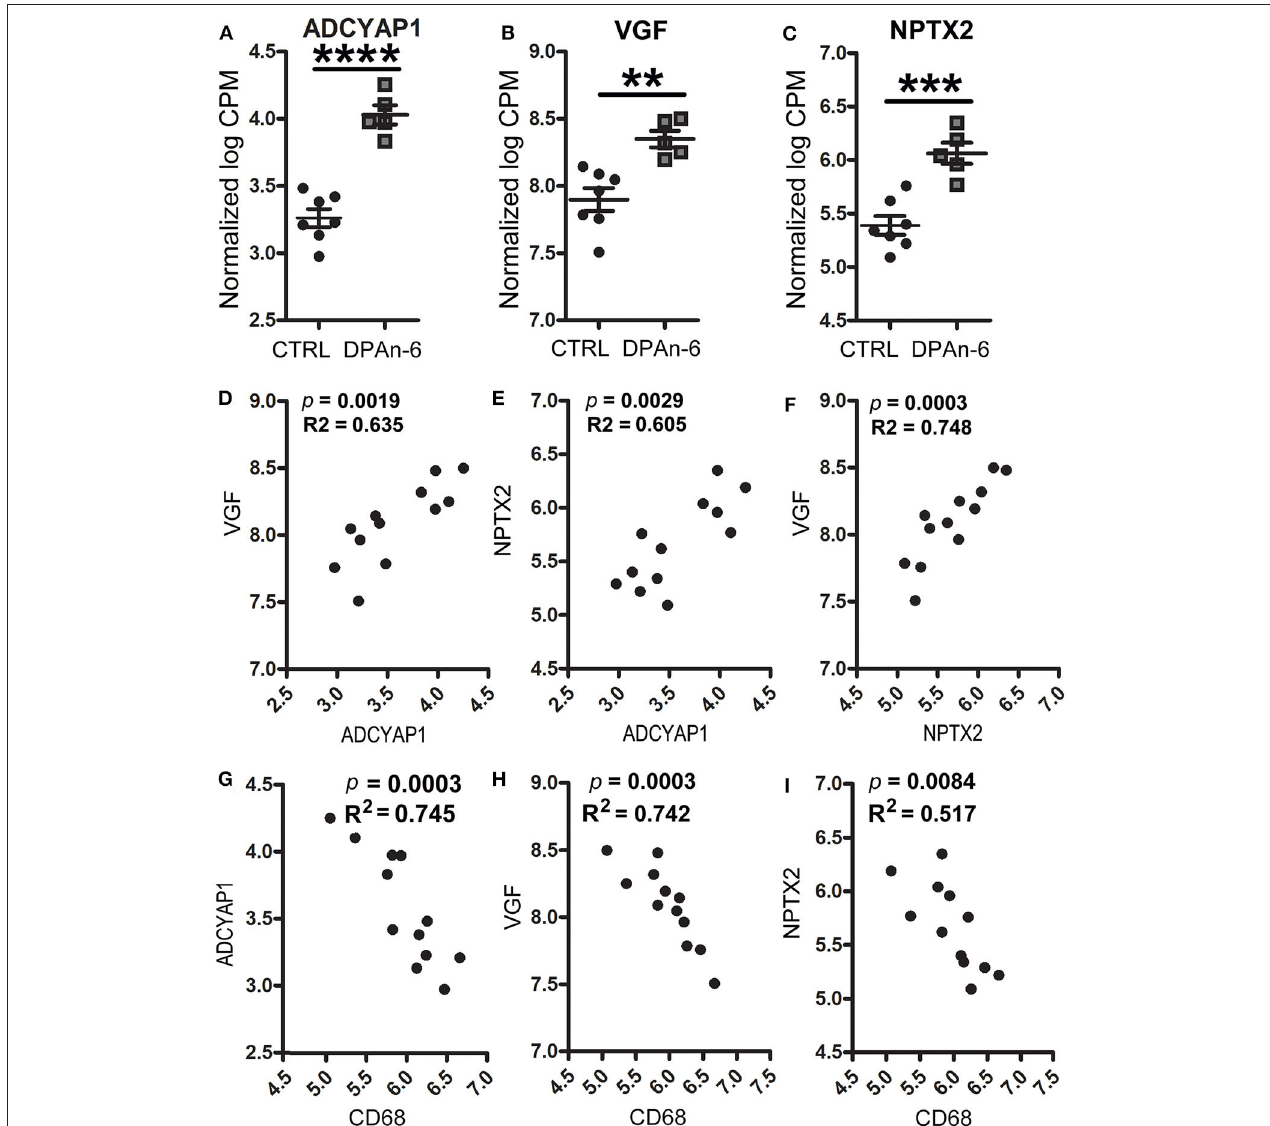
FIGURE 5 | DPAn-6 increased mRNA expression of ADCYAP1, VGF, and NPTX2, which were inversely correlated with activated microglia in aged E4FAD mice. In RNA-Seq data, (A-C) DPAn-6 significantly increased gene expressions of ADCYAP1 ( p < 0.0001, A ), VGF ( p < 0.01, B ), and NPTX2 ( p < 0.001, C ). (D–F) These neuronal markers were positively correlated with each other. ADCYAP1 was positively correlated with VGF ( p = 0.0019, R 2 = 0.635, D ) and NPTX2 ( p = 0.0029, R 2 = 0.605, E ). NPTX2 was positively correlated with VGF ( p = 0.0003, R 2 = 0.748, F ). (G–I) The microglial activation marker CD68 is was inversely correlated with ADCYAP1 ( p = 0.0003, R 2 = 0.745, G ), VGF ( p = 0.0003, R 2 = 0.742, H ), and NPTX2 ( p = 0.0084, R 2 = 0.517, I ). The RNA-Seq data were normalized by Count Per Million (CPM) and presented as Log2 expression. Data represent the mean ± SEM. Significance was determined using an unpaired, two-tailed Student’s t -test, ** p < 0.01, *** p < 0.001, and **** p <